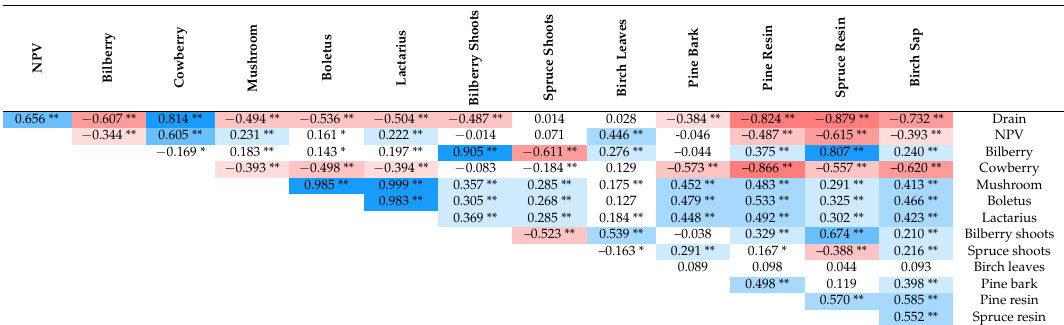
Table 3. Correlation matrix among timber drain and net present value (NPV) and yields of non-wood forest products obtained by following a total of 214 holding-level forest plans in spruce-dominated forest holding.